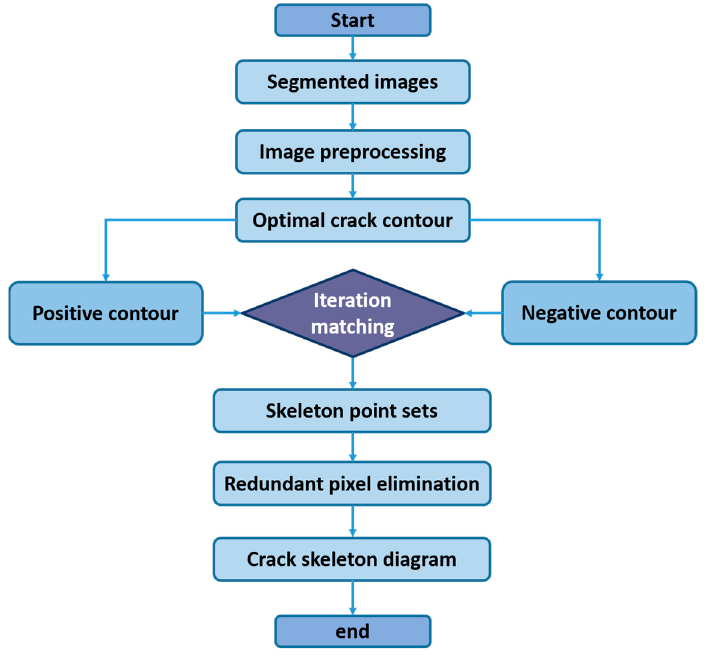
Figure 7. Flowchart of the proposed crack skeleton extraction algorithm.